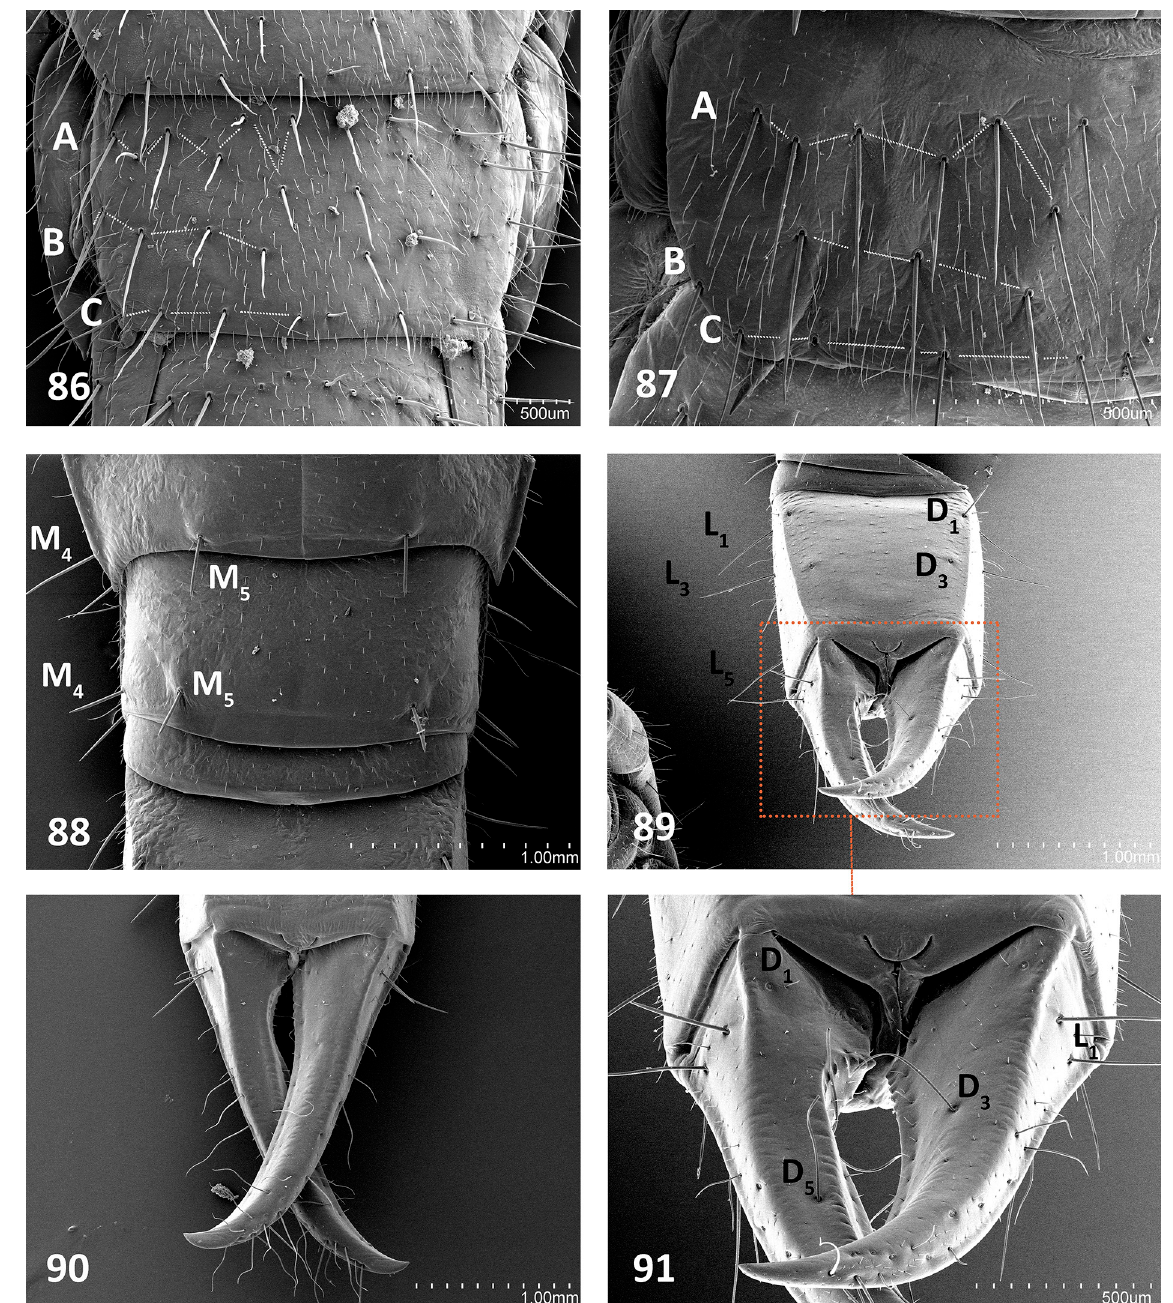
Figs 86‒91. Mueggejapyx brehieri Sendra & Komerički gen. et sp. nov. 86 . Eighth and ninth urosternites. 87 . Fourth urosternite. 88 . Eighth and ninth urotergites. 89 . Urite X and cerci, dorsal side. 90 . Cerci, dorsal side. 91 . Detail of the cerci, dorsal side. Abbreviations: see Material and